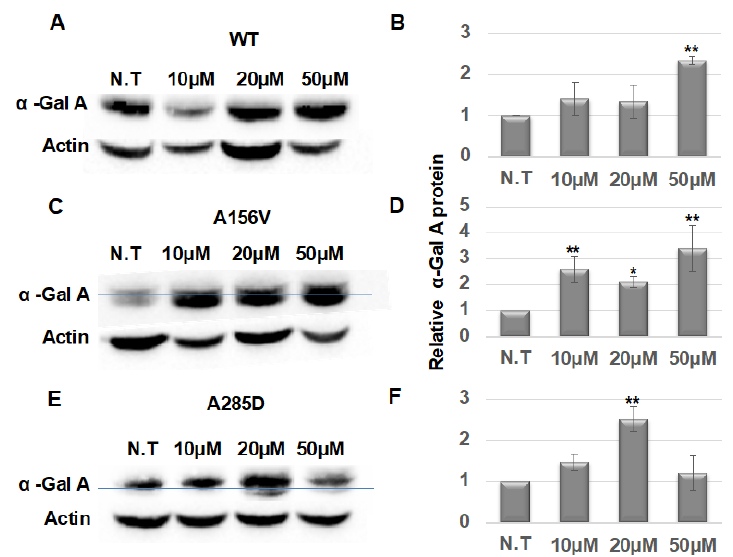
Figure 2. Alpha-Gal A expression following migalastat treatment. ( A , C , E ) Lysates prepared from 22 day old flies, carrying the di ff erent α -Gal A variants, as indicated in the graph, treated with di ff erent migalastat concentrations, were subjected to SDS–PAGE and interaction with anti-Myc antibody, to identify α -Gal A and anti actin antibodies, as a loading control. Blue lines separate the higher molecular weight ER retained fraction of the protein from the lower molecular weight lysosomal fraction (when applicable). ( B , D , F ) Quantification of results as shown in ( A , C , E ), respectively. To quantify the results, α -Gal A intensity in each lane was divided by that of actin in the same lane, and the number obtained for N.T. in each experiment was considered to be 1. The results are the mean ± SEM of three independent experiments. The expression of the α -Gal A mutant variants was under the daughterless GAL4 driver (DaGAL4). Statistical analysis included two-way ANOVA (to determine significant di ff erences between genotypes’ reactions to concentrations) followed by one-way ANOVA with post-hoc Dunnett t-tests. Significance: * p < 0.05; ** p < 0.01. N.T: